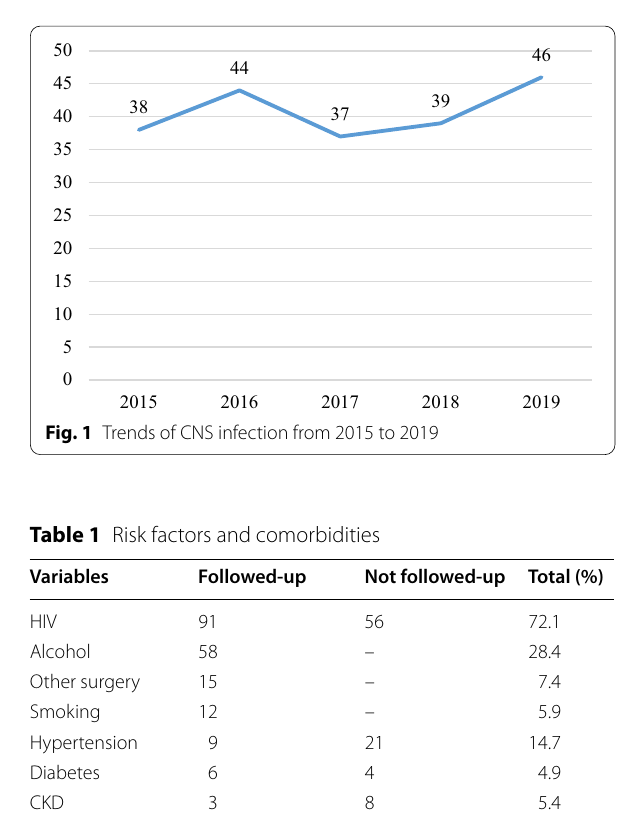
CKD chronic kidney disease, HIV human immunodeficiency virus